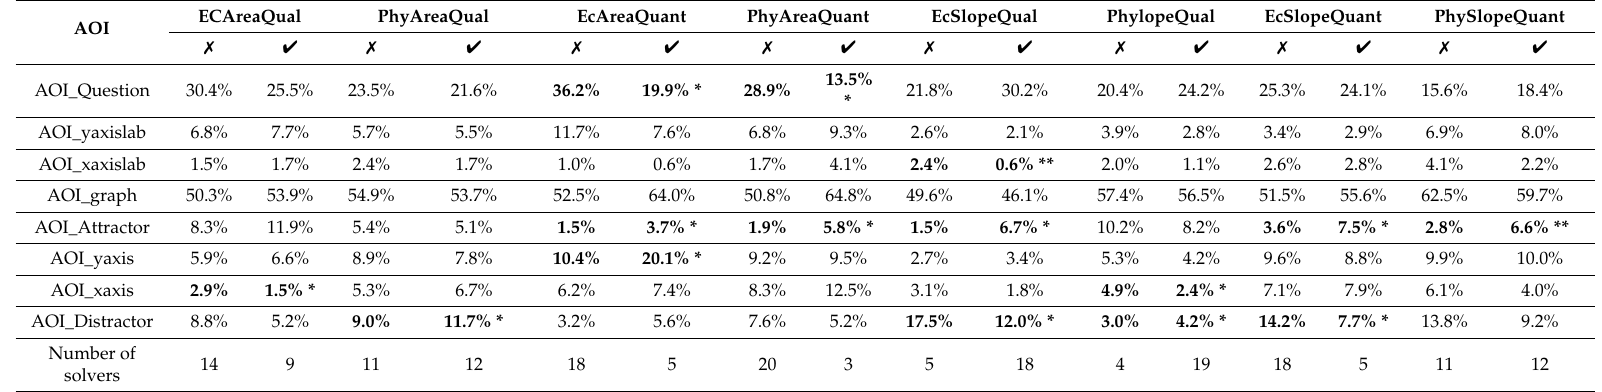
Table 3. Average number of fixations of correct and incorrect solvers for each task in percent (significant di ff erences in bold; * p > 0.5; ** p >